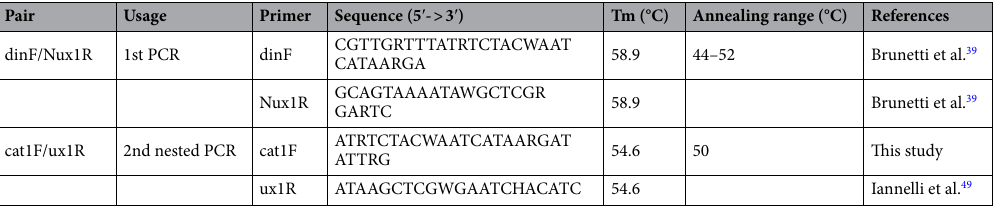
Table 1. Primer pairs used in this